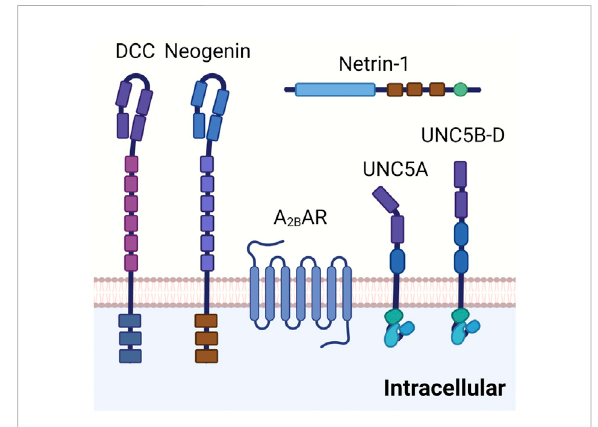
FIGURE 3 Netrin-1 receptors. DCC is a transmembrane protein composed of four immunoglobulin like repeats and six fi bronectin type II like repeats on the extracellular site. It is involved in the netrin-1 mediated bi-functional guidance of neurons. Neogenin shares a similar structure to DCC and has been implicated in tissue morphogenesis, angiogenesis, as well as axon guidance. Adora2b has been identi fi ed as a netrin-1 coreceptor in netrin-1 signaling incertaintissues, although detailed mechanisms are still under investigation. UNC5 receptors (UNC5A-D) are composed of two immunoglobulin like repeats and two throbomspondin domains in the extracellular area. UNC5 receptors have been suggested in the long range and short range repulsion during axon